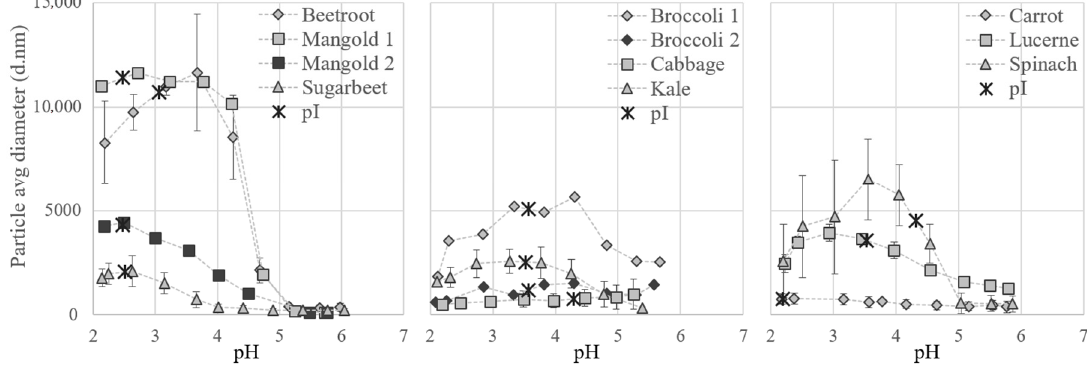
Figure 7. Particle size of white protein in thermally treated supernatant (fraction S2) from the different crops at different pH values during titration. Isoelectric point (pI) of S2 is marked on the respective